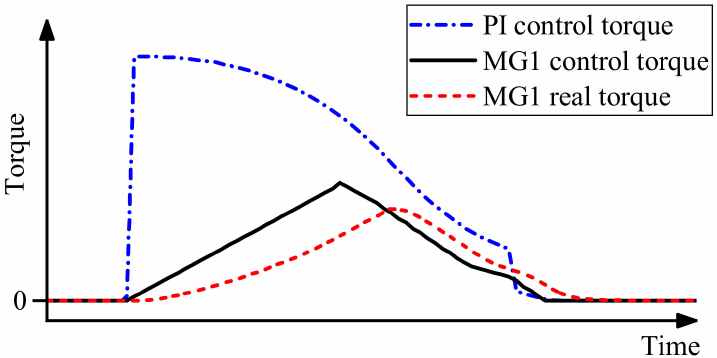
Figure 5. Comparison among the PI control torque, MG1 control torque, and MG1 real